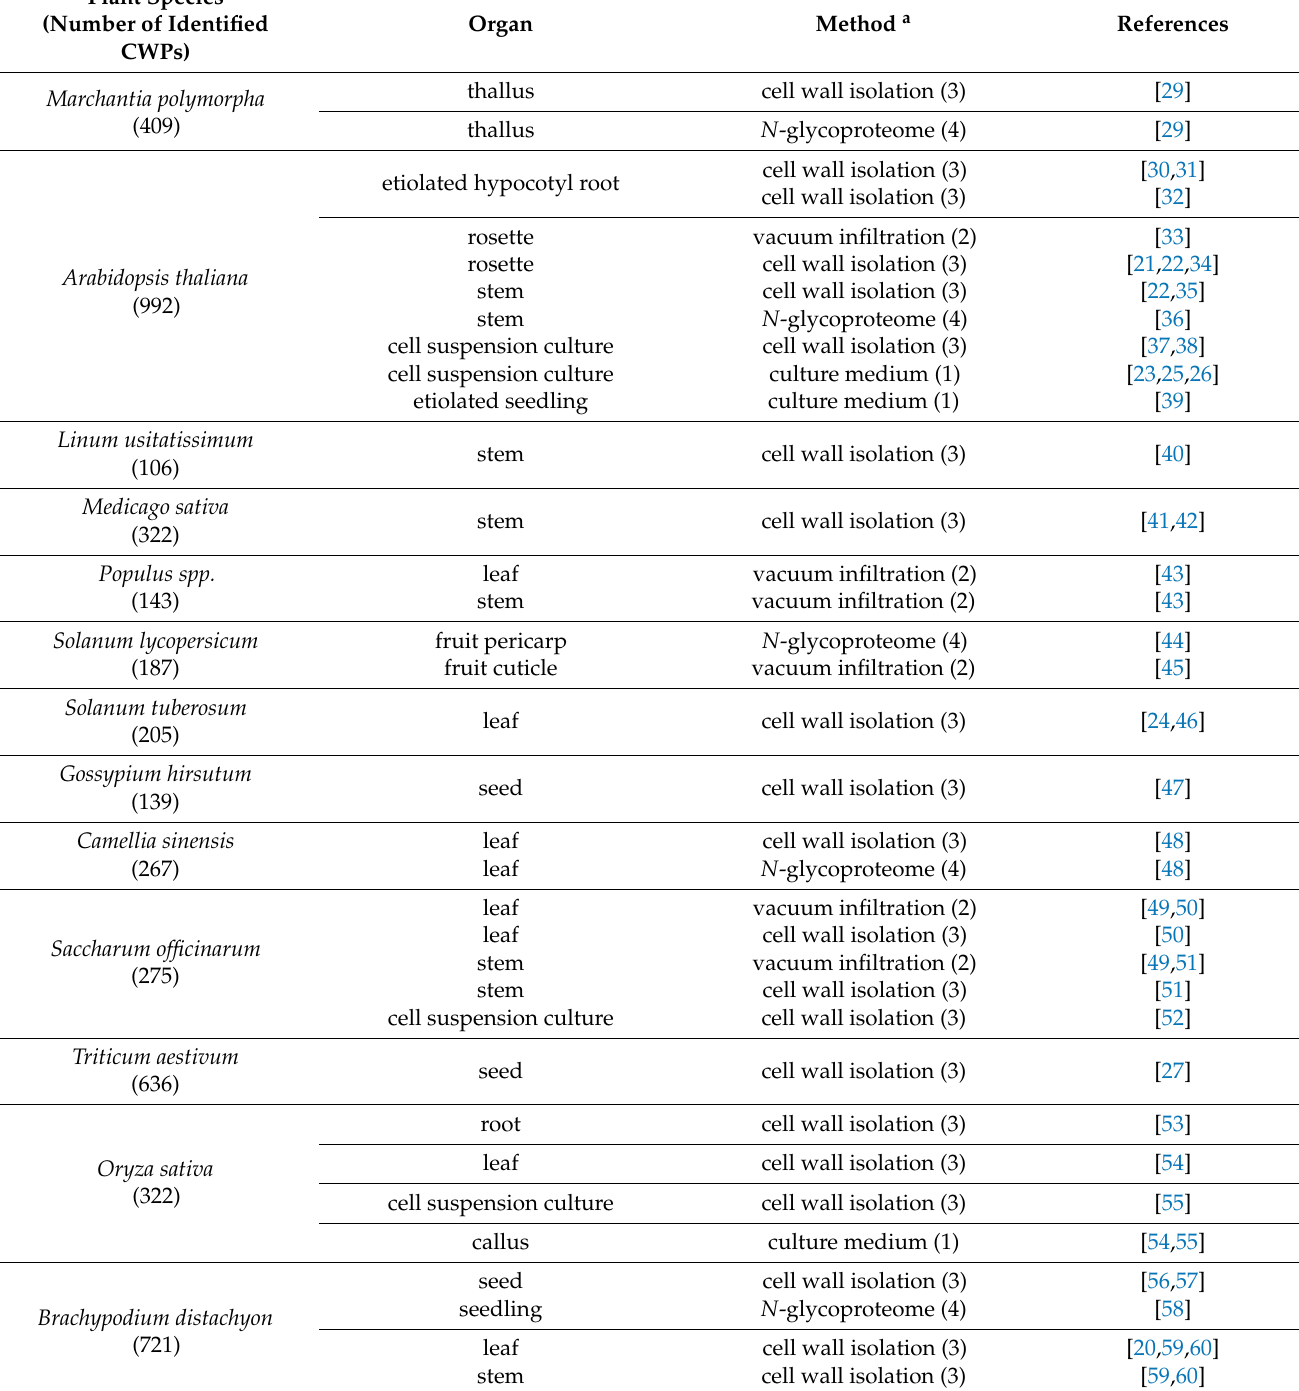
Table 1. The plant cell wall proteomes analyzed in this